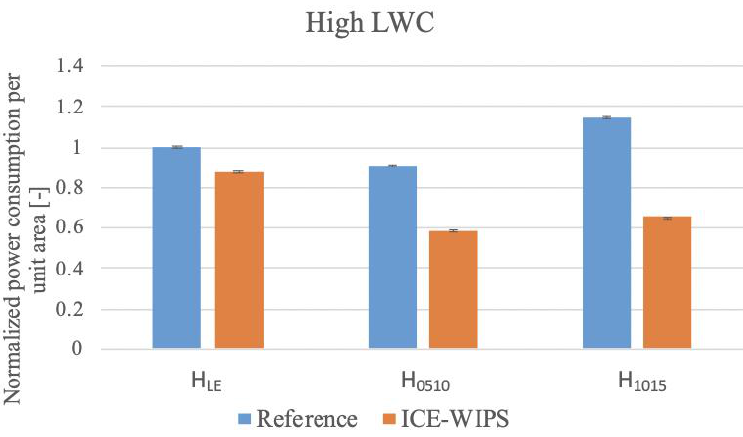
Figure 13. Normalized power consumption per unit area of each heating area for High LWC case. Table 4. Summary of normalized power consumption per unit area in demonstration test.